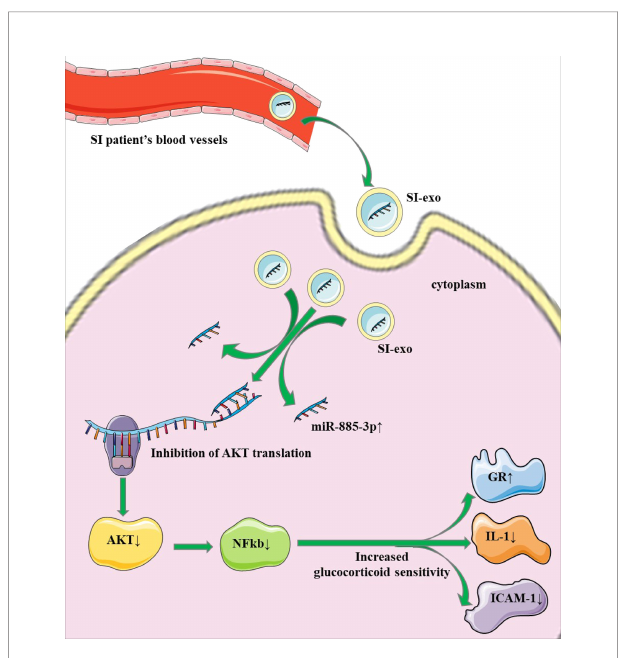
FIGURE 6 | Mechanism pattern of exosome mir-885-3p improving the glucocorticoid sensitivity of